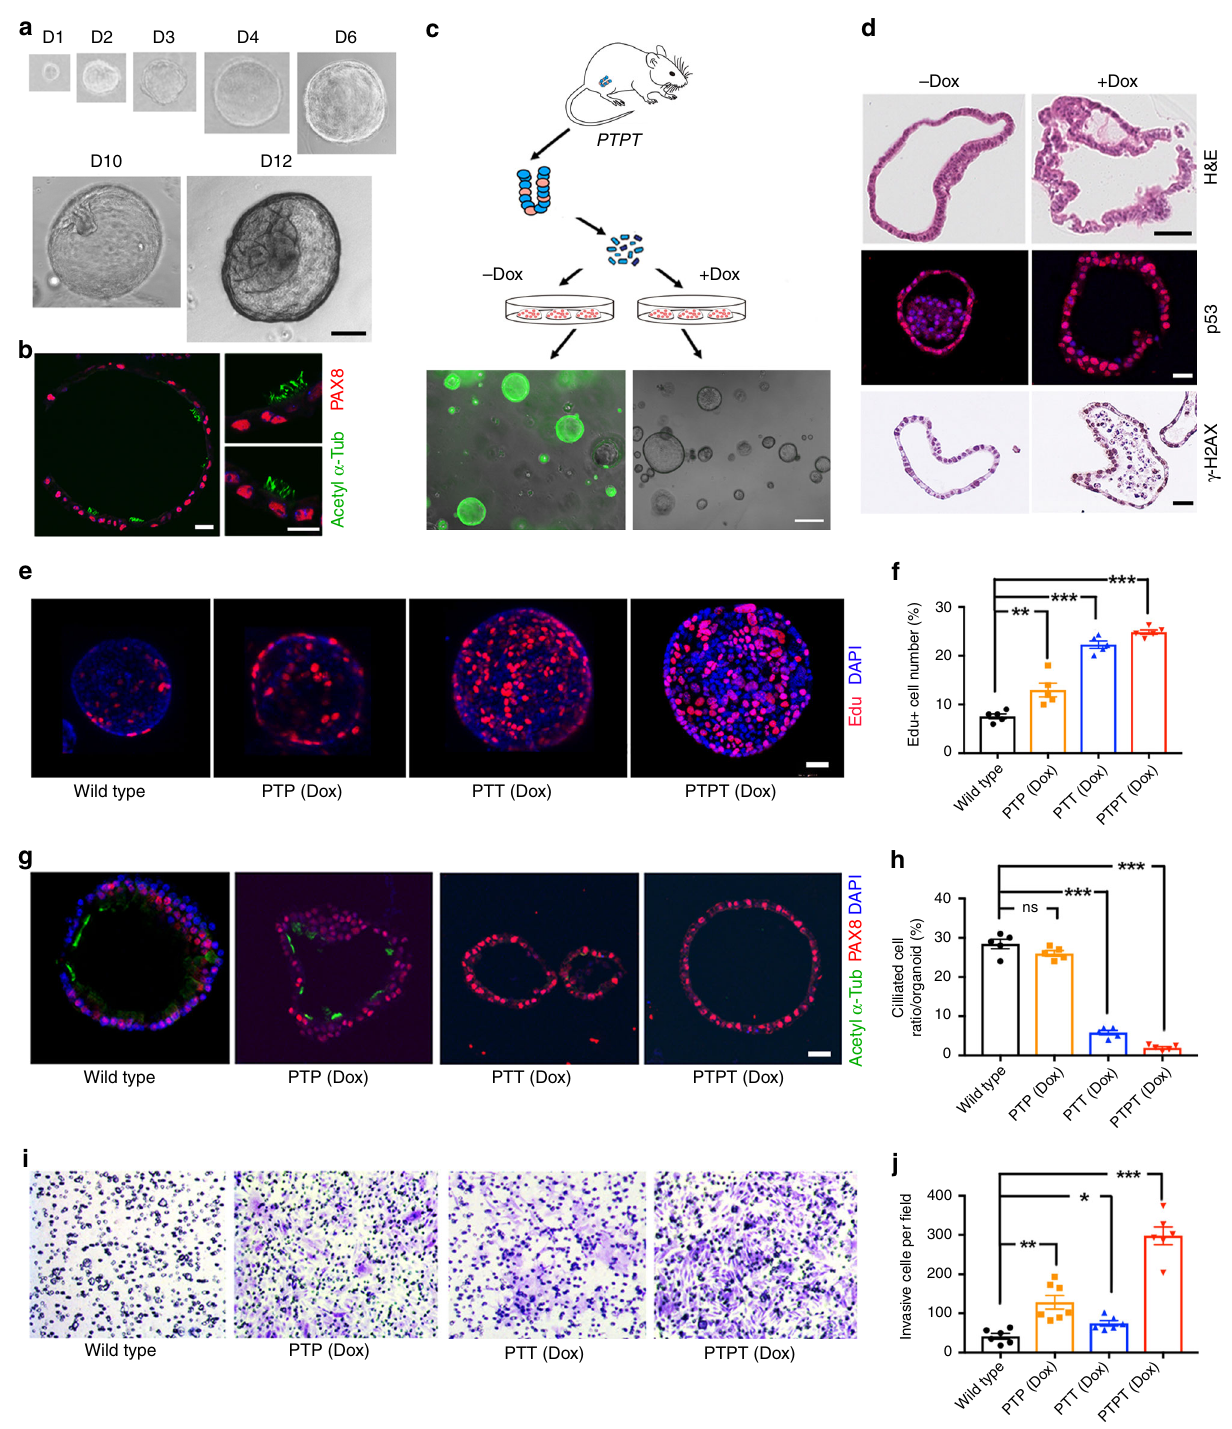
peritoneal carcinomatosis and ascites (Fig. 4d, f). Histology and IHC revealed poorly differentiated adenocarcinoma with papillary and micropapillary/ fi ligree morphology (Fig. 4g), resembling human HGSOC. Notably, these tumors showed little PAX8 staining. As an additional test of whether Lgr5 + OSE cells directly evoke HGSOC transformation, we generated compound LPT; Rosa26- tdTomato mice (Fig. 5a), administered one dose of 4-OHT, and analyzed mice at 3, 6, or 9 months (Fig. 5b). At 3 months after Cre activation, neoplasia had developed from Lgr5 + cells (Fig. 5c).